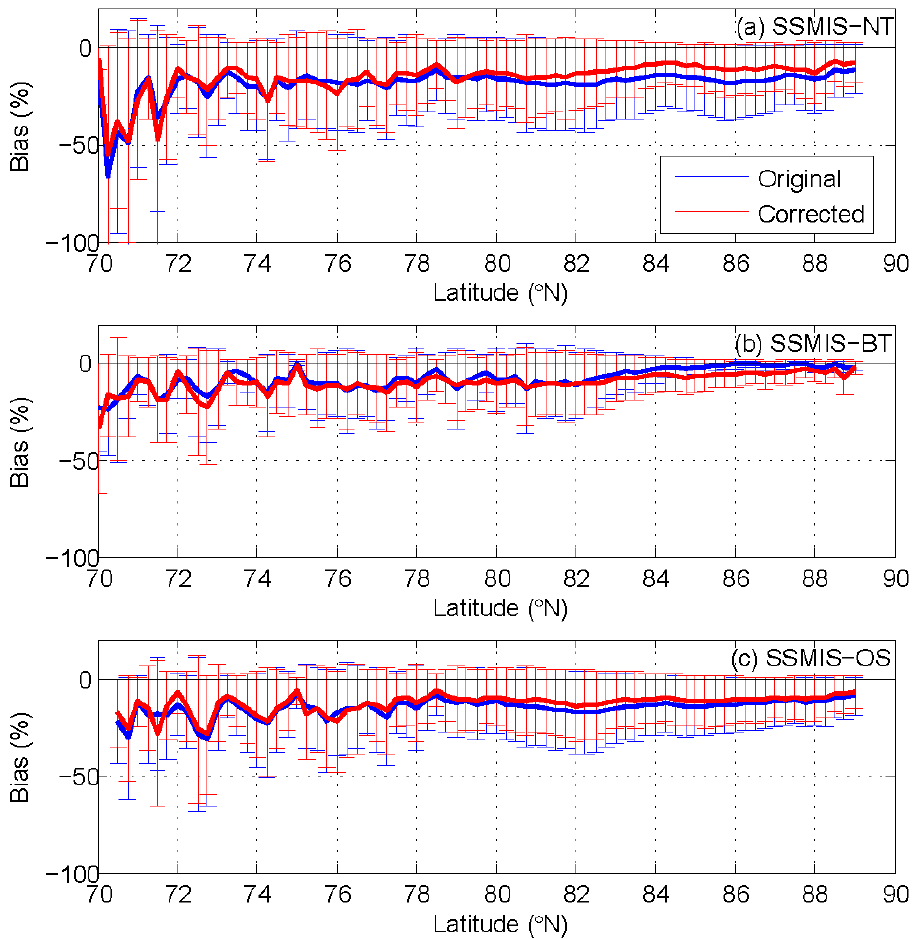
Figure 11. The zonal mean distribution of the SIC biases ± 1 STD for the three original (blue lines) and corrected (red lines) SSMIS-based products: ( a ) SSMIS-NT, ( b ) SSMIS-BT and ( c ) SSMIS-OS, for 6 September 2019, corresponding to Figure 10.